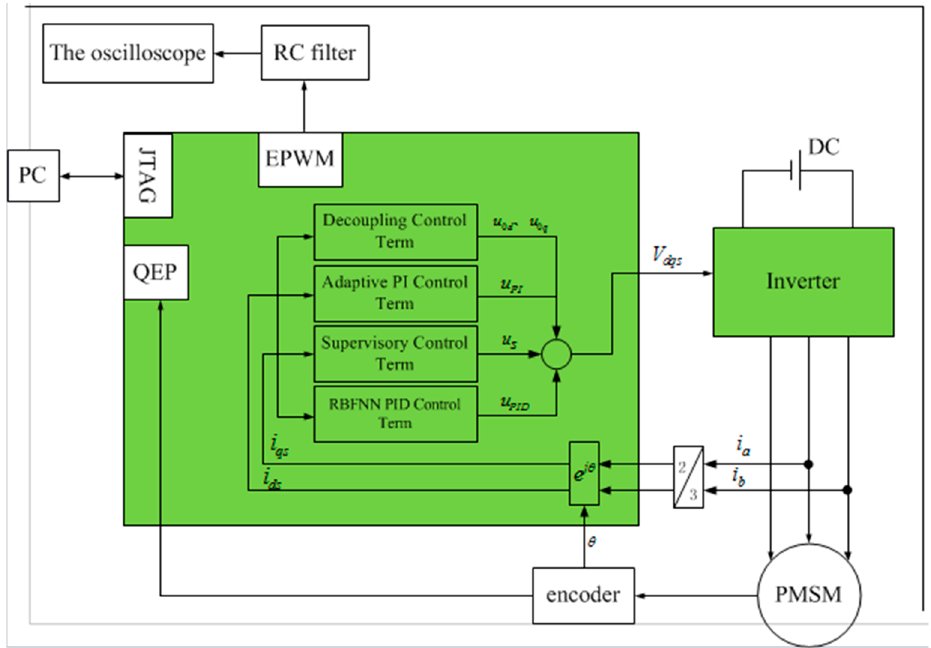
Figure 3. General structure diagram of the sPMSM drive system using the designed adaptive PI + RBFNN-PID controller.